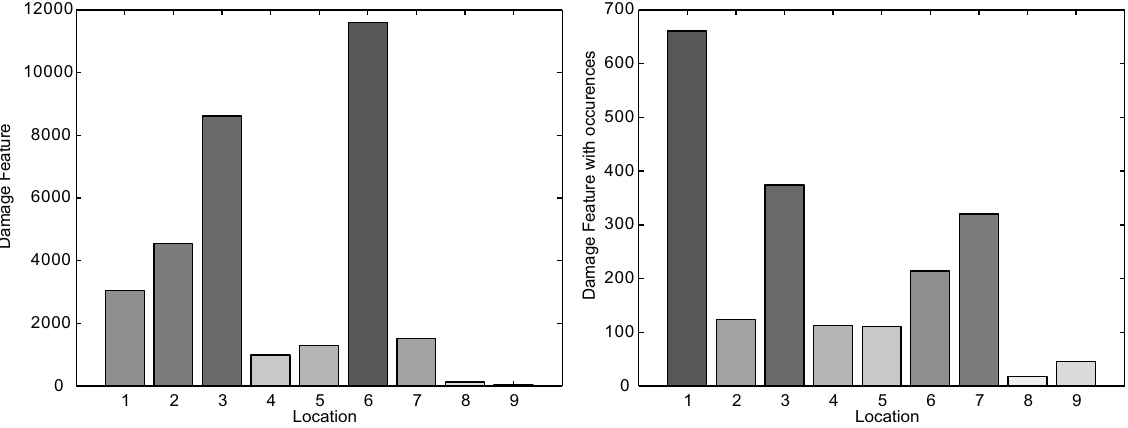
Fig. 9. Damage feature without and with occurrences for undamaged structure and changing loading conditions, frequency range 1–200 Hz.